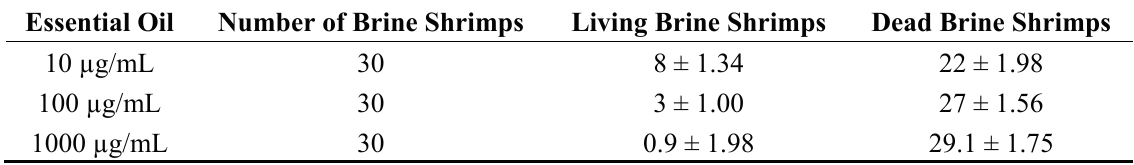
Data are the mean ± SEM of three